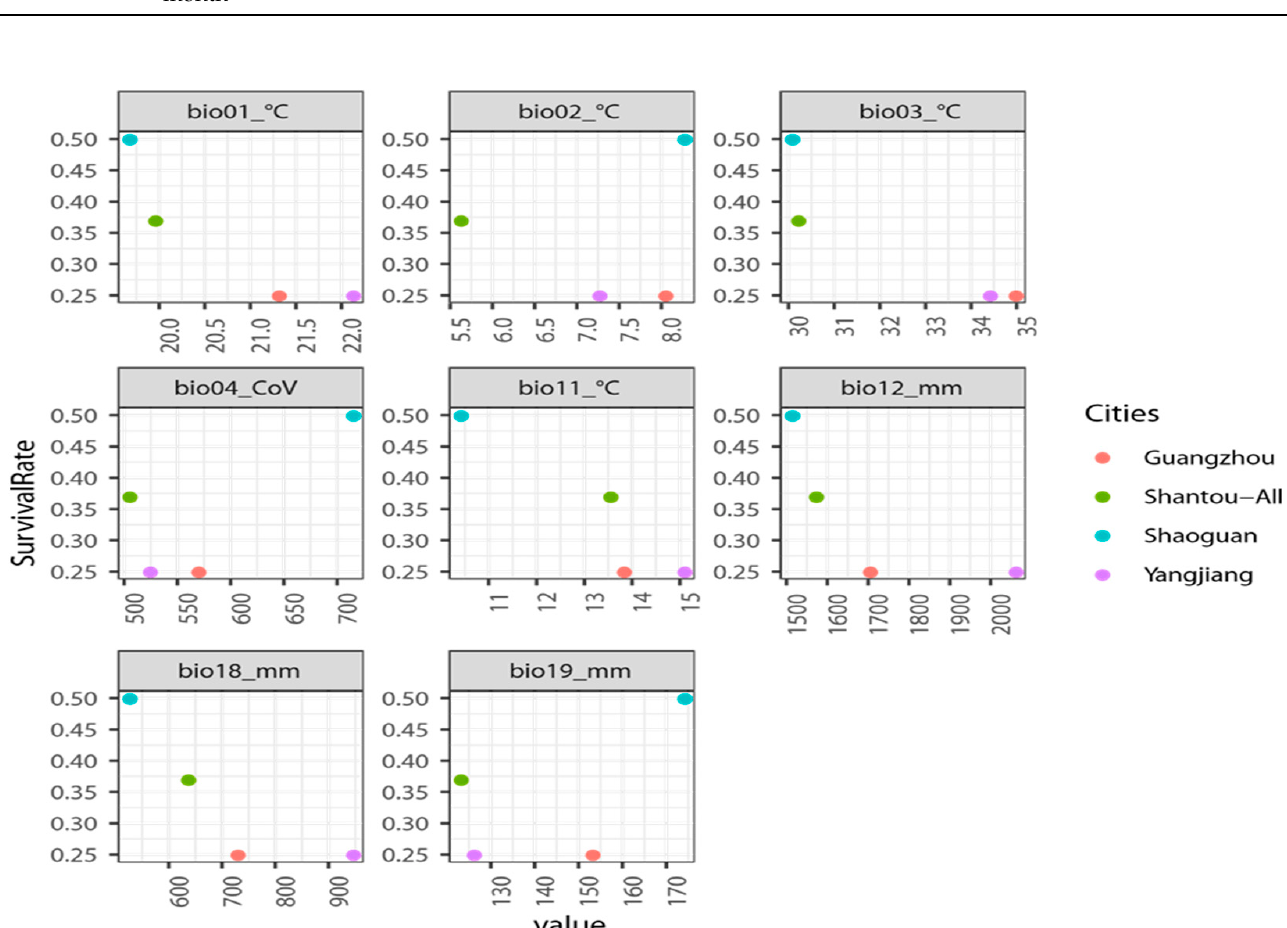
Figure 3. Survival rates of reintroduced seedlings at study sites based on the most important environmental variables according to assessments within the MaxEnt ENM framework. Survival rates were averaged across the three adjacent sites in Shantou, where the original population occurs.